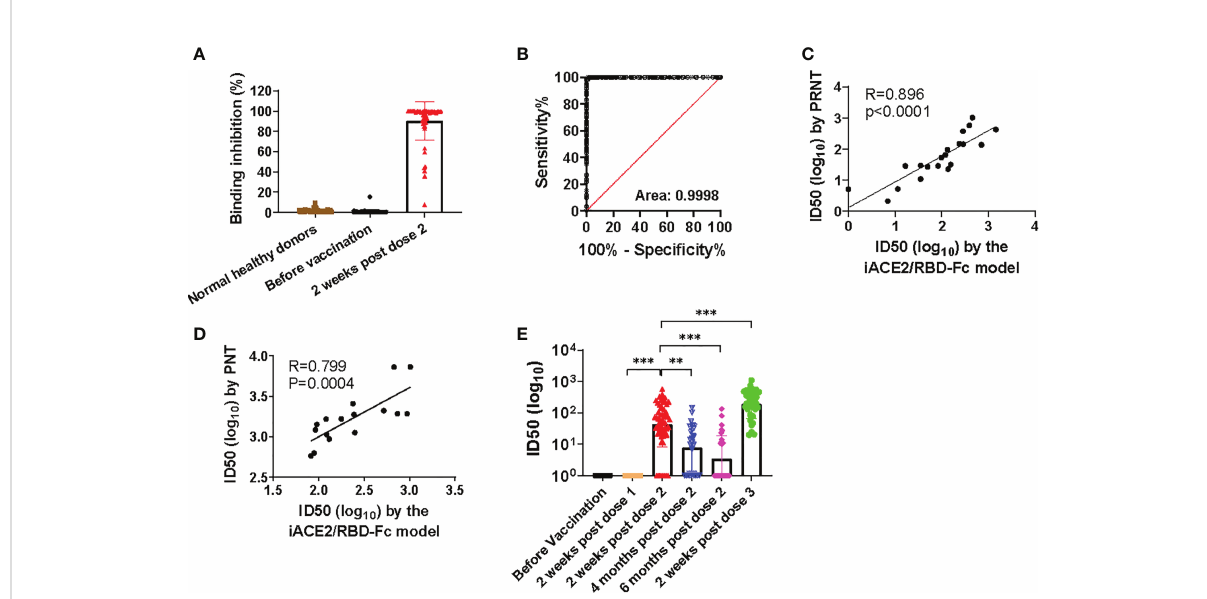
FIGURE 4 Assessment of sensitivity, speci fi city, accuracy and validation of iACE2/RBD-Fc model. To assess sensitivity and speci fi city of iACE2/RBD-Fc model, paired serum samples collected from 60 donors before the 1st dose of immunization and at two weeks post the 2nd dose of immunization were 5-fold diluted, then determined by iACE2/RBD-Fc model for activity to inhibit binding of the RBD-Fc on the ACE2 bead. The binding inhibition activity of each sample was shown in Panel (A) ROC curve analysis of the data shown in (A) was shown in (B) . To assess accuracy of iACE2/RBD-Fc model, ID50 values of 12 convalescent plasma samples and 8 vaccine serum samples were determined by the PRNT and the iACE2/RBD-Fc model, and ID50 values of 16 convalescent plasma samples were determined by the PNT and the iACE2/RBD-Fc model. The correlation of ID50 values determined by two assays of the PRNT/the iACE2/RBD-Fc model and two assays of the PNT/the iACE2/RBD-Fc model was shown in (C, D) , respectively. ID50 values of serum samples collected from the SARS-CoV-2 vaccine recipients at different time points during the vaccination course were determined by iACE2/RBD-Fc model and shown with its geometric mean in Panel (E) P<0.01 and 0.001 are represented as ** and ***,